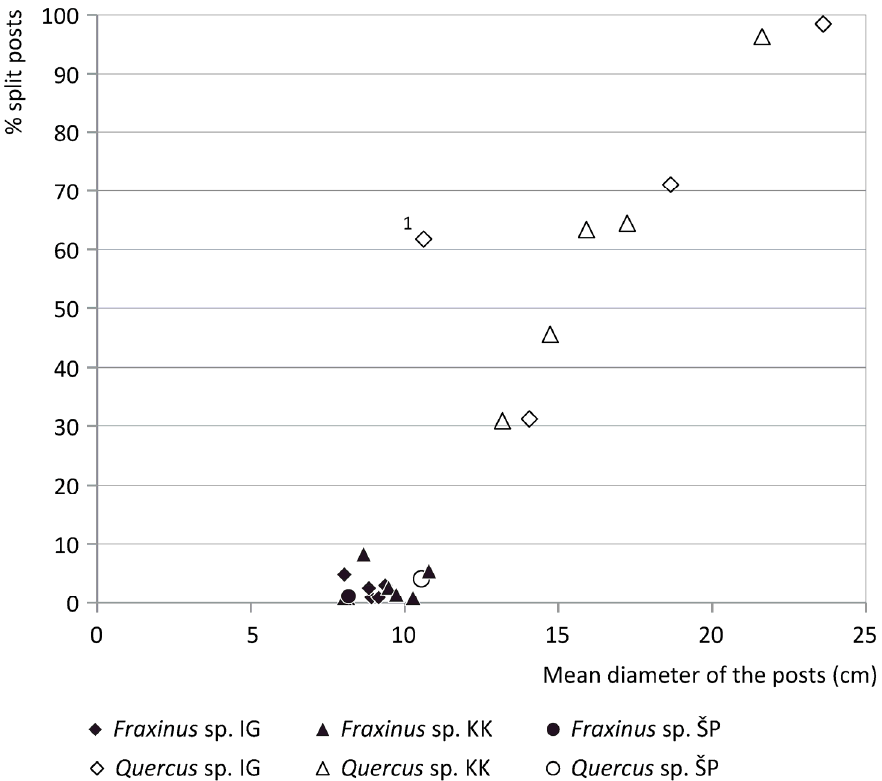
Figure 4. Scatterplot showing the percentage of split posts in relation to the mean diameter for ash and oak. Each data point represents a site. The dataset includes all sites with >50 posts with diameter data as well as oak data from Č rnelnik ( n = 27). 1 = Maharski prekop. IG = cluster Ig, KK = cluster Kamnik pod Krimom, ŠP = Špica.